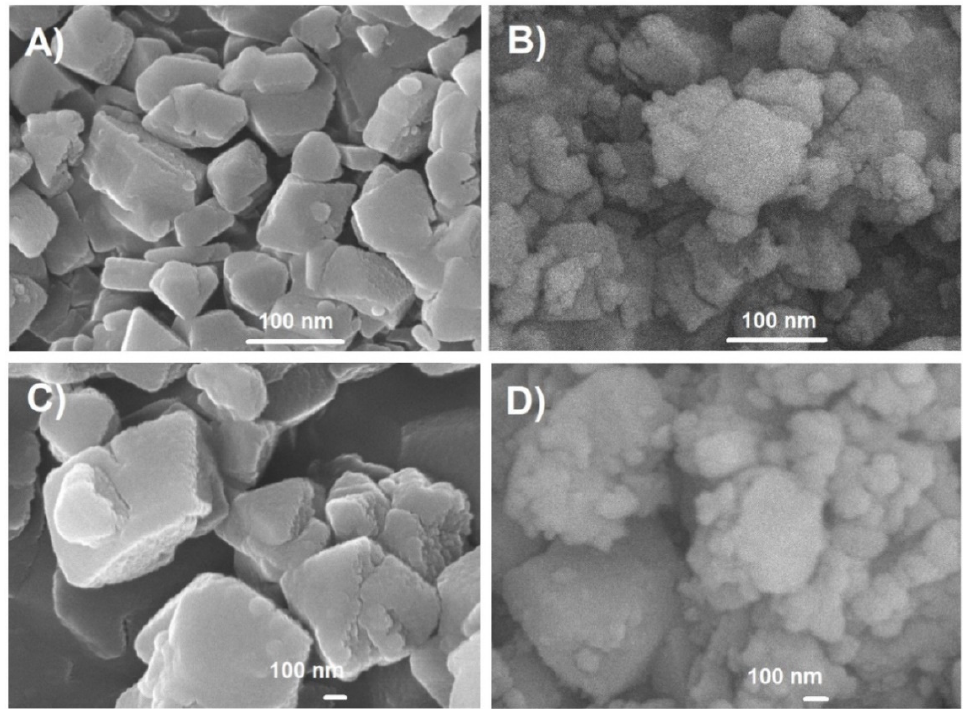
Figure A2. SEM images of the parent sample: fresh H-Z: ( A ) 25,000 x, ( B ) 50,000 x; spent H-Z: ( C ) 25,000 x, ( D ) 50,000 x.